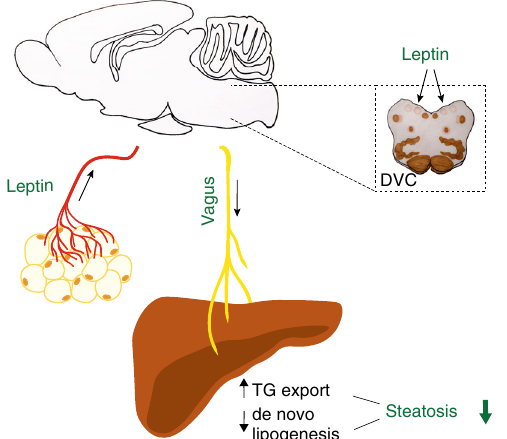
Fig. 6 Proposed model of the role of CNS leptin in regulating hepatic lipid metabolism. Leptin secreted by white adipocytes protects the liver from ectopic lipid accumulation and lipotoxicity. Leptin reaches the brain by passing through the blood – brain barrier to increase TG secretion and reduce hepatic de novo lipogenesis via signaling in the dorsal vagal complex, where the efferent vagal motor neurons are located. These centrally mediated leptin effects require intact liver vagal innervation and are preserved under HFD-conditions when leptin is administered directly into the